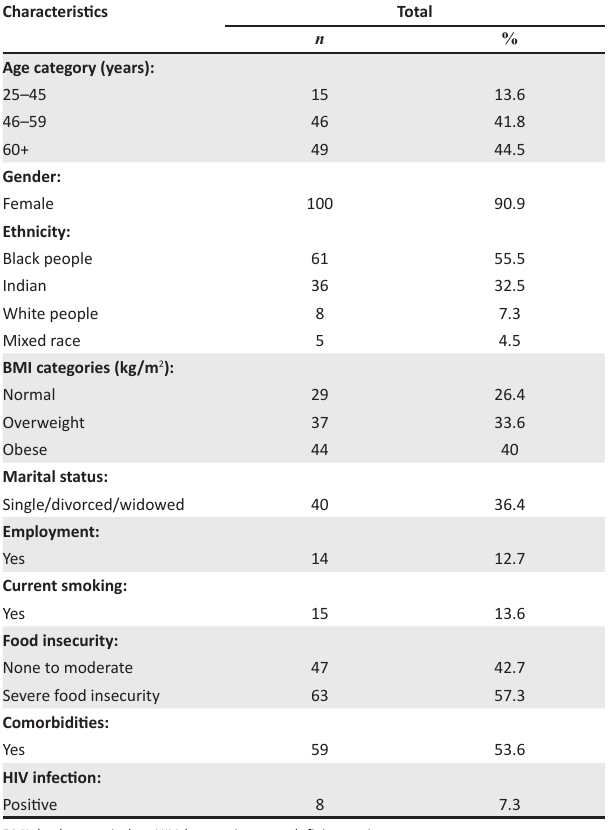
TABLE 1: Socio-demographic and clinical characteristics of 110 participants with rheumatoid arthritis.